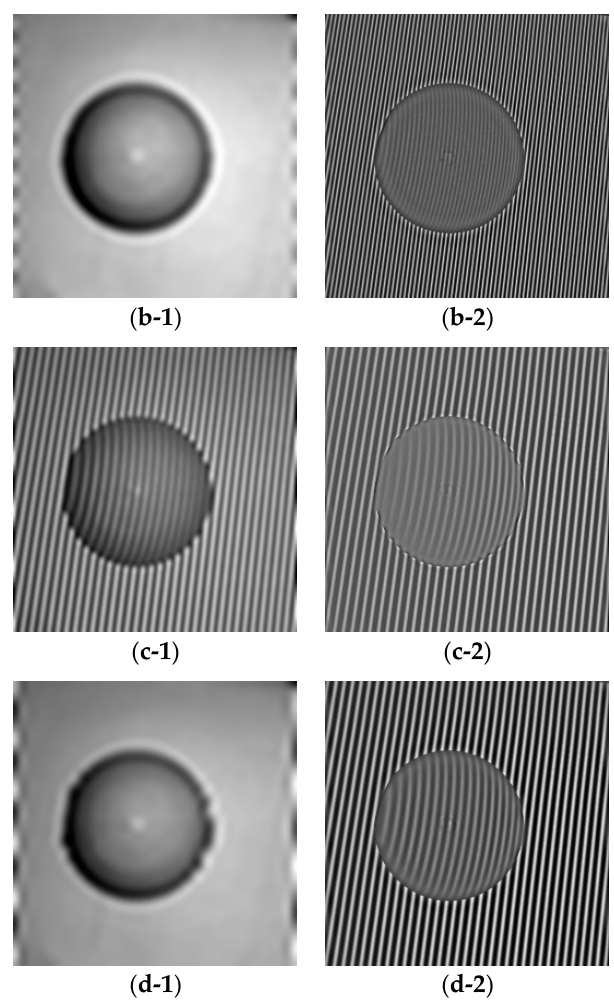
Figure 10. The decomposed background and fringe of Figure 3 by Shearlet transform method with decomposition layer 3 and 4. ( a-1 ) decomposed background from Figure 3a with decomposition layer 3; ( b-1 ) decomposed background from Figure 3a with decomposition layer 4; ( c-1 ) decomposed background from Figure 3b with decomposition layer 3; ( d-1 ) decomposed background from Figure 3b with decomposition layer 4; ( a-2 ) decomposed fringe from Figure 3a with decomposition layer 3; ( b-2 ) decomposed fringe from Figure 3a with decomposition layer 4; ( c-2 ) decomposed fringe from Figure 3b with decomposition layer 3; ( d-2 ) decomposed fringe from Figure 3b with decomposition layer 4.